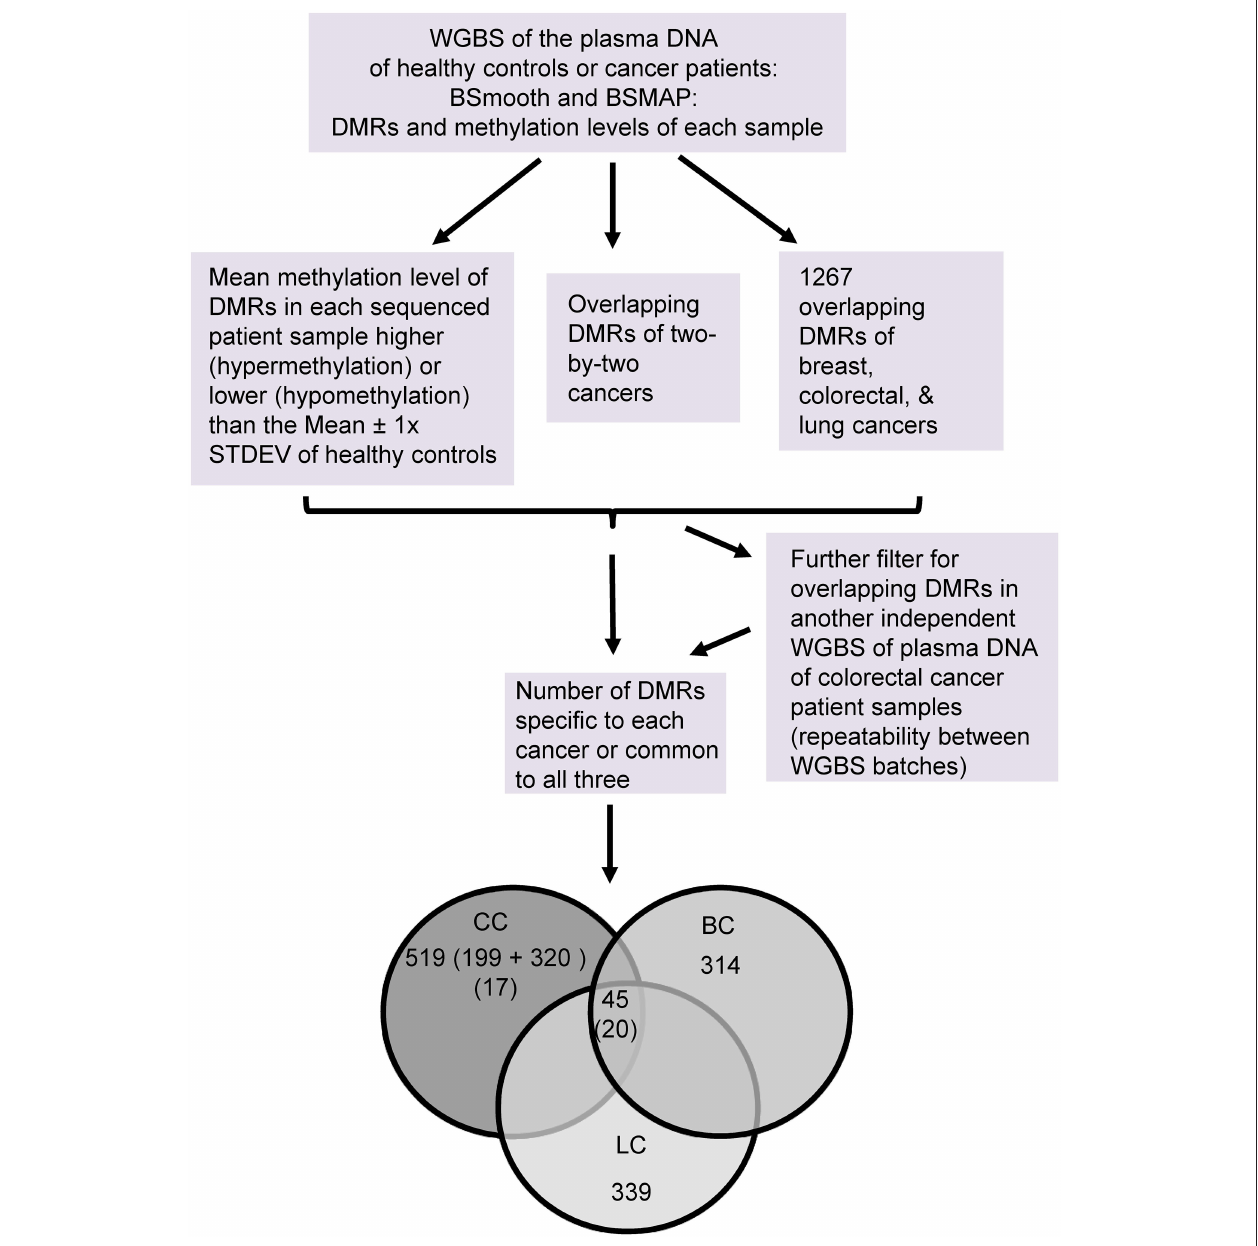
FIGURE 4 | Flowchart of the WGBS analysis of the plasma DNA of early stage cancers of humans. Number of DMRs in each group are as indicated. The numbers of DMRs found in both batches of colon cancers are bracketed. CC: colorectal cancer, BC: breast cancer, and LC: lung cancer.